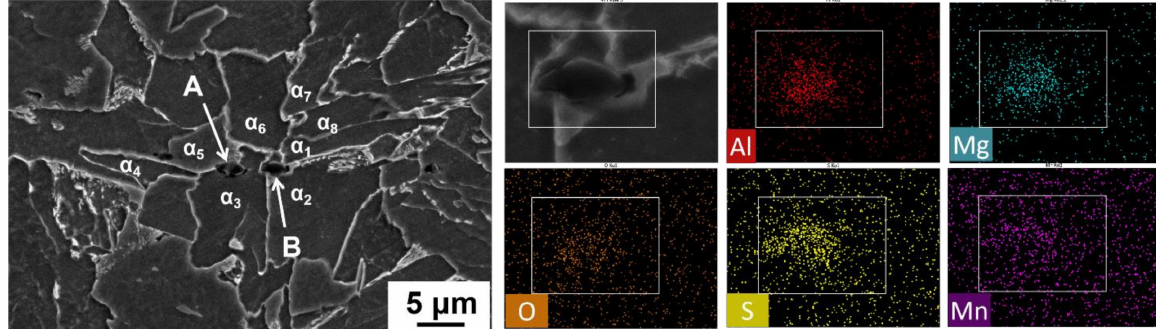
Figure 13. Mapping scanning results and the relationship between the Al–Mg–O+MnS and ferrite in the HAZ of Mg-treated steel at W2 heat input.